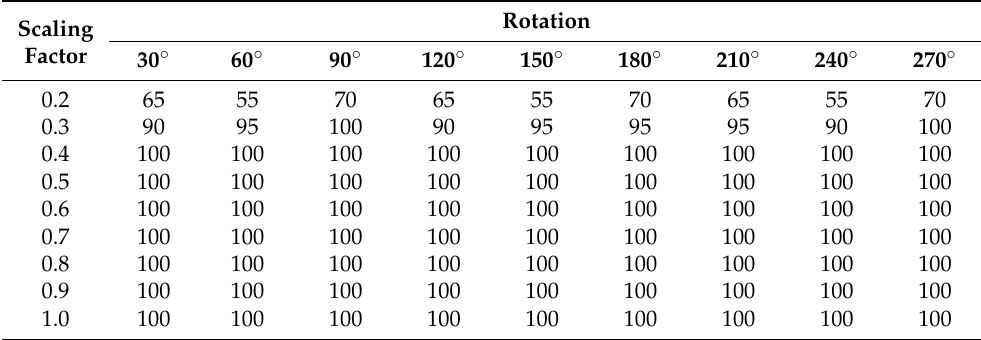
Table 4. The correct recognition rates for a combination of rotation angles and scaling factors for the proposed method for the 2D aircraft dataset.